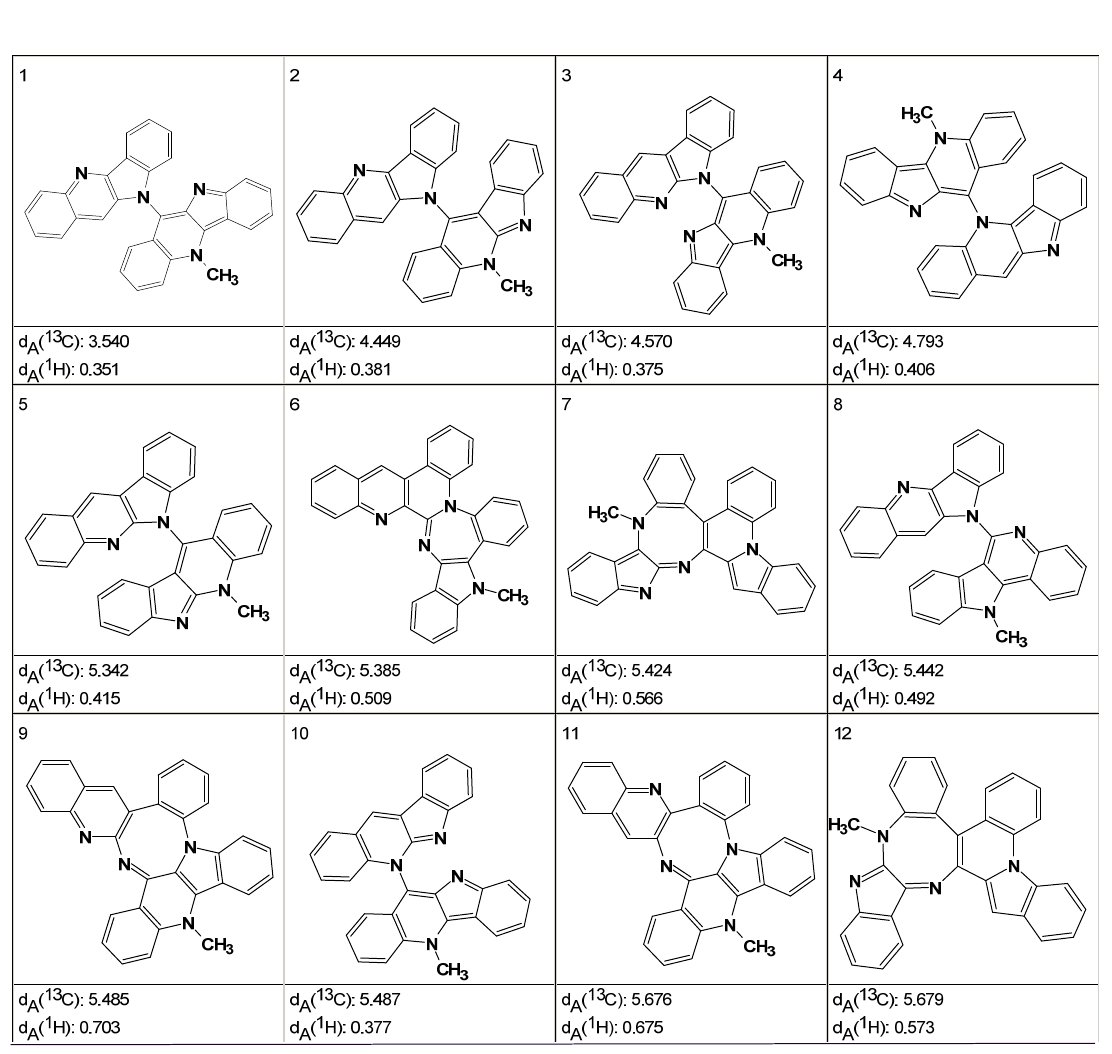
Figure 10. Twelve top ranked structures.